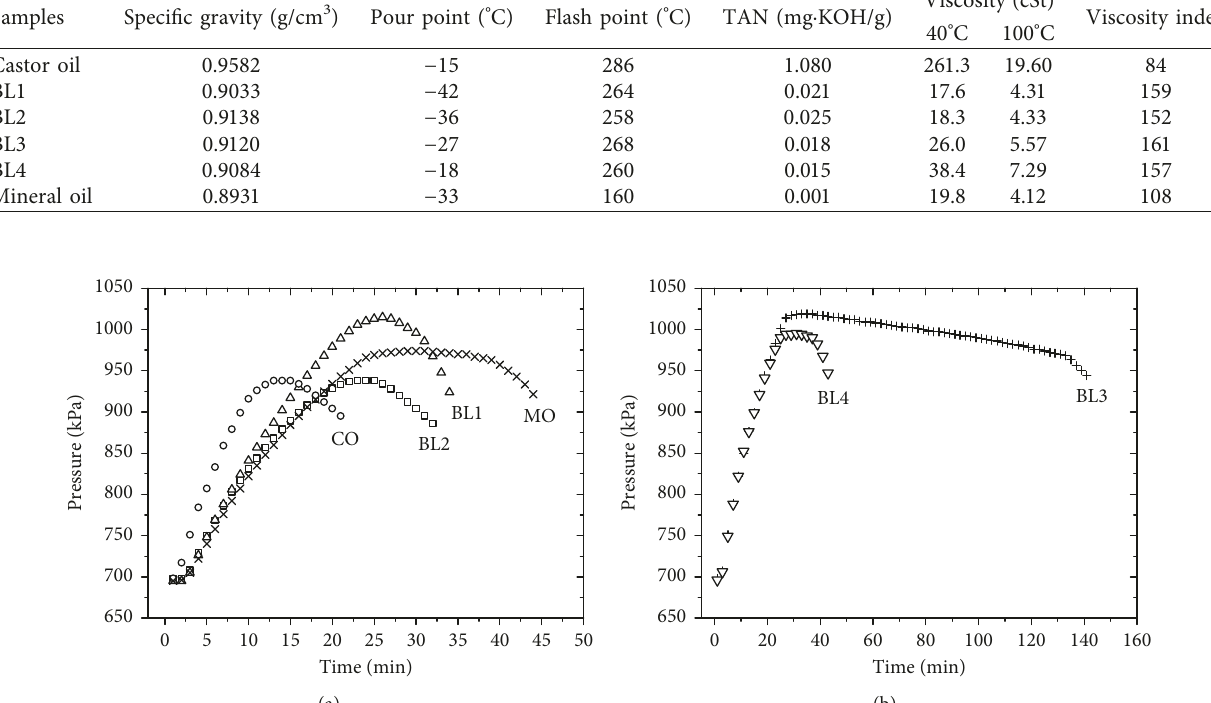
Table 1: Physicochemical properties of bio-based lubricants, castor oil and mineral oil. Samples